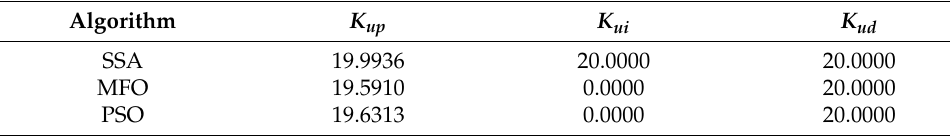
Figure 8. Convergence rate curve of the fitness of angular displacement during the optimization process, ( a ) optimize the cascade PID controller, ( b ) optimize the fuzzy adaptive PID controller. Table 5. Proportion factor optimization results of fuzzy